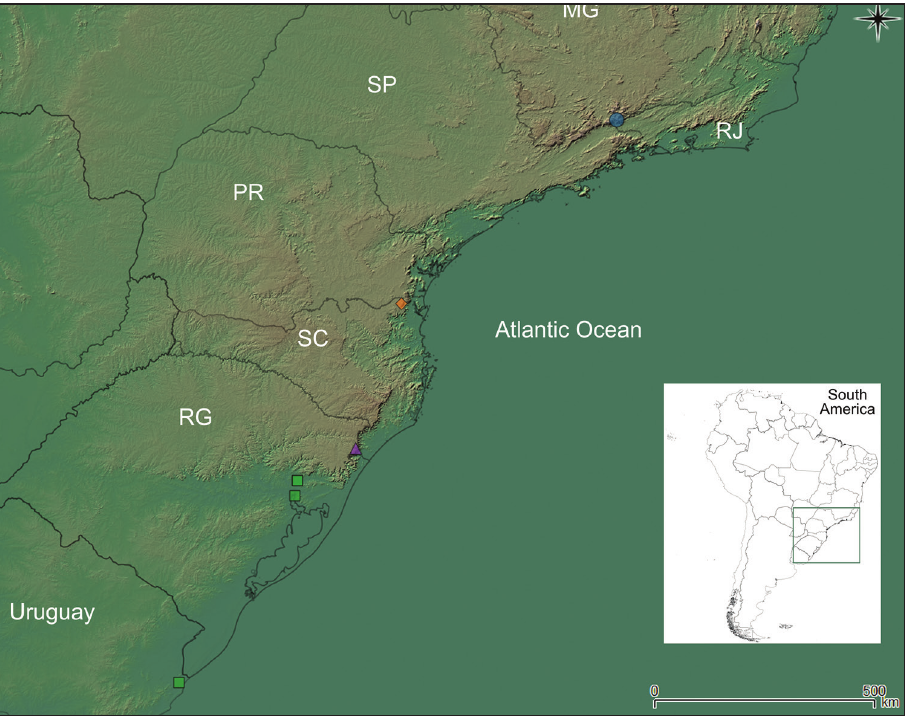
Figure 2. Geographical distribution of Isoetes nana (blue circle), I. maxima (purple triangle), I. quiririensis (orange diamond) and I. weberi (green squares) in southeastern South America. In Brazil: MG=Minas Gerais; PR=Paraná; RJ=Rio de Janeiro; RS=Rio Grande do Sul; SC=Santa Catarina; SP=São